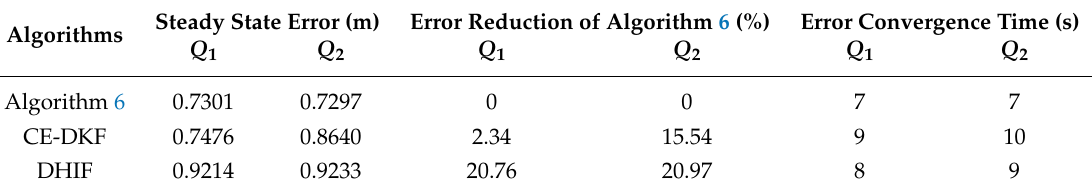
Table 1. Error performance comparison of different algorithms.